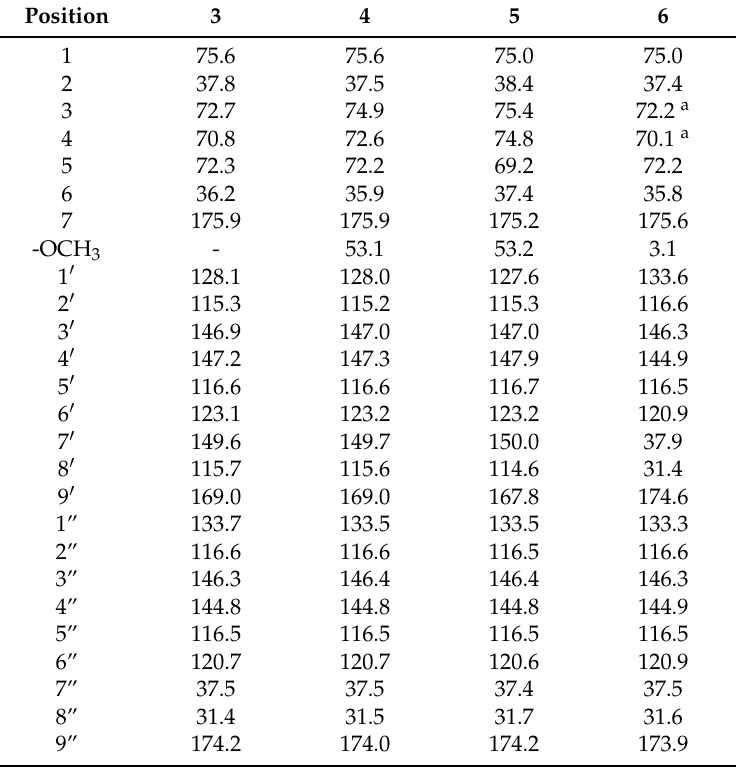
Table 2. 13 C-NMR (125 MHz) data for 3 – 6 in CD 3